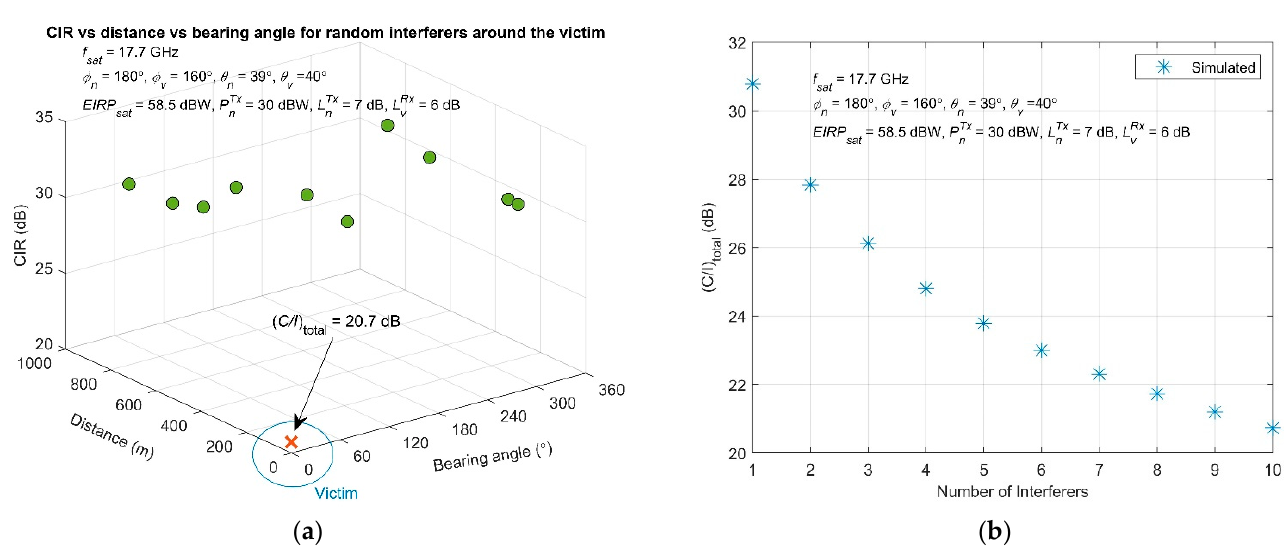
Figure 8. Examined scenario having multiple interferers around the victim: ( a ) achieved independent CIR for each interferer for random distance and bearing angle. The total CIR is also depicted; ( b ) obtained total CIR at the victim side versus the number of interfering stations.